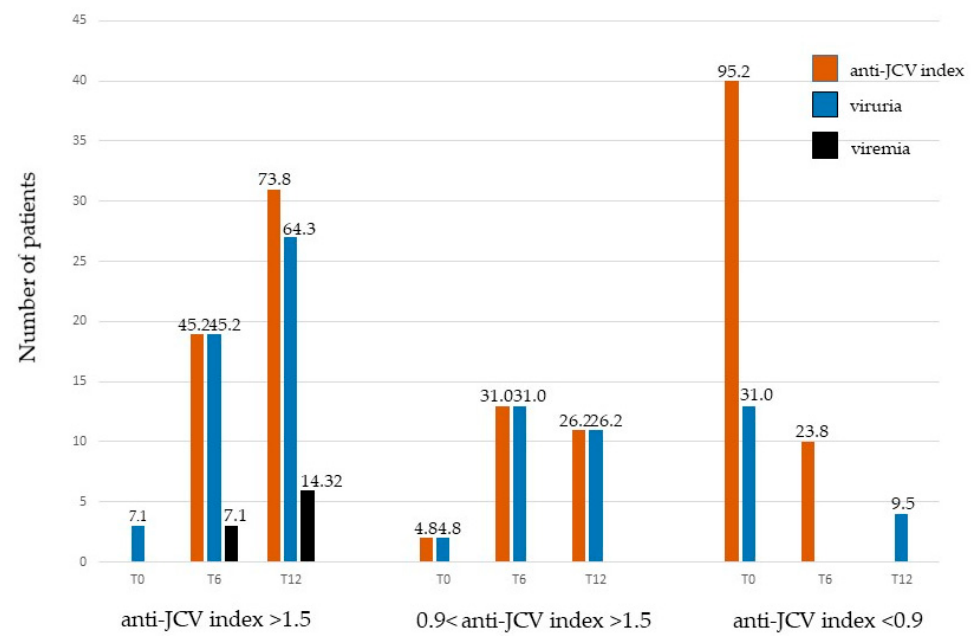
Figure 1. Relationship between serostatus and JCPyV DNA in 42 individuals with MS. T0: before starting treatments, no drug administration; T6: 6 months after the beginning of therapy; T12: 12 months after the beginning of therapy. The number on top of each bar indicates the percentage of MS persons with anti-JCV index, viruria and viremia, respectively. The absence of a bar indicates that none of the individuals with MS had the indicated anti-JCV index, viruria and viremia, respectively.